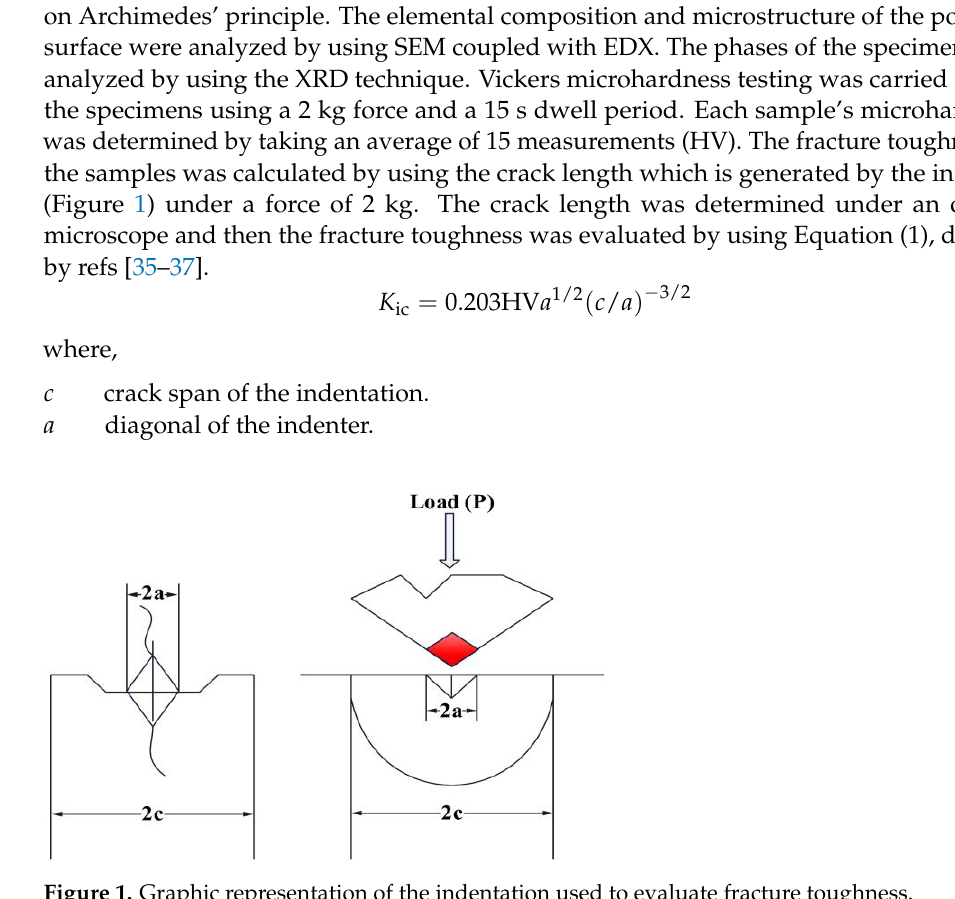
Figure 1. Graphic representation of the indentation used to evaluate fracture toughness.